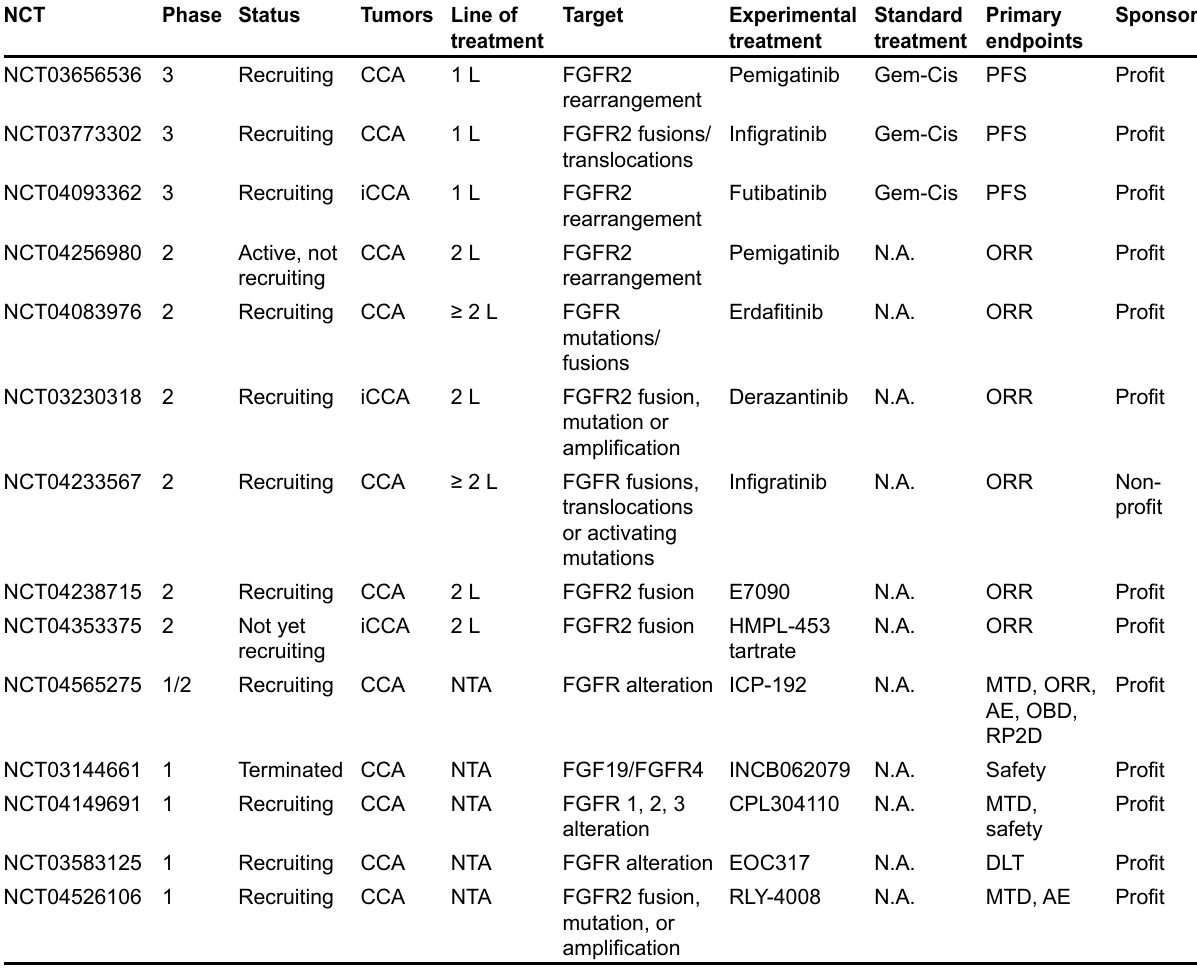
Table 1. Active trials, both recruiting and not recruiting, with FGFR’s inhibitors described above NCT Phase Status Tumors Line